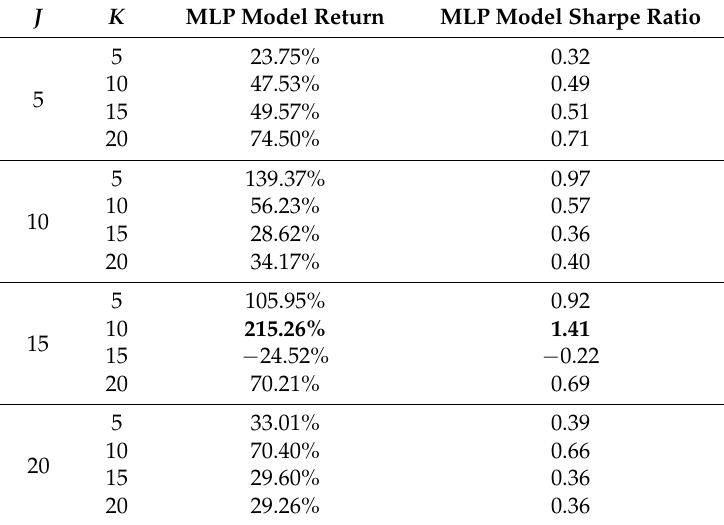
Table 8. Performance of the Multilayer Perceptron Neural Network (MLP) model.